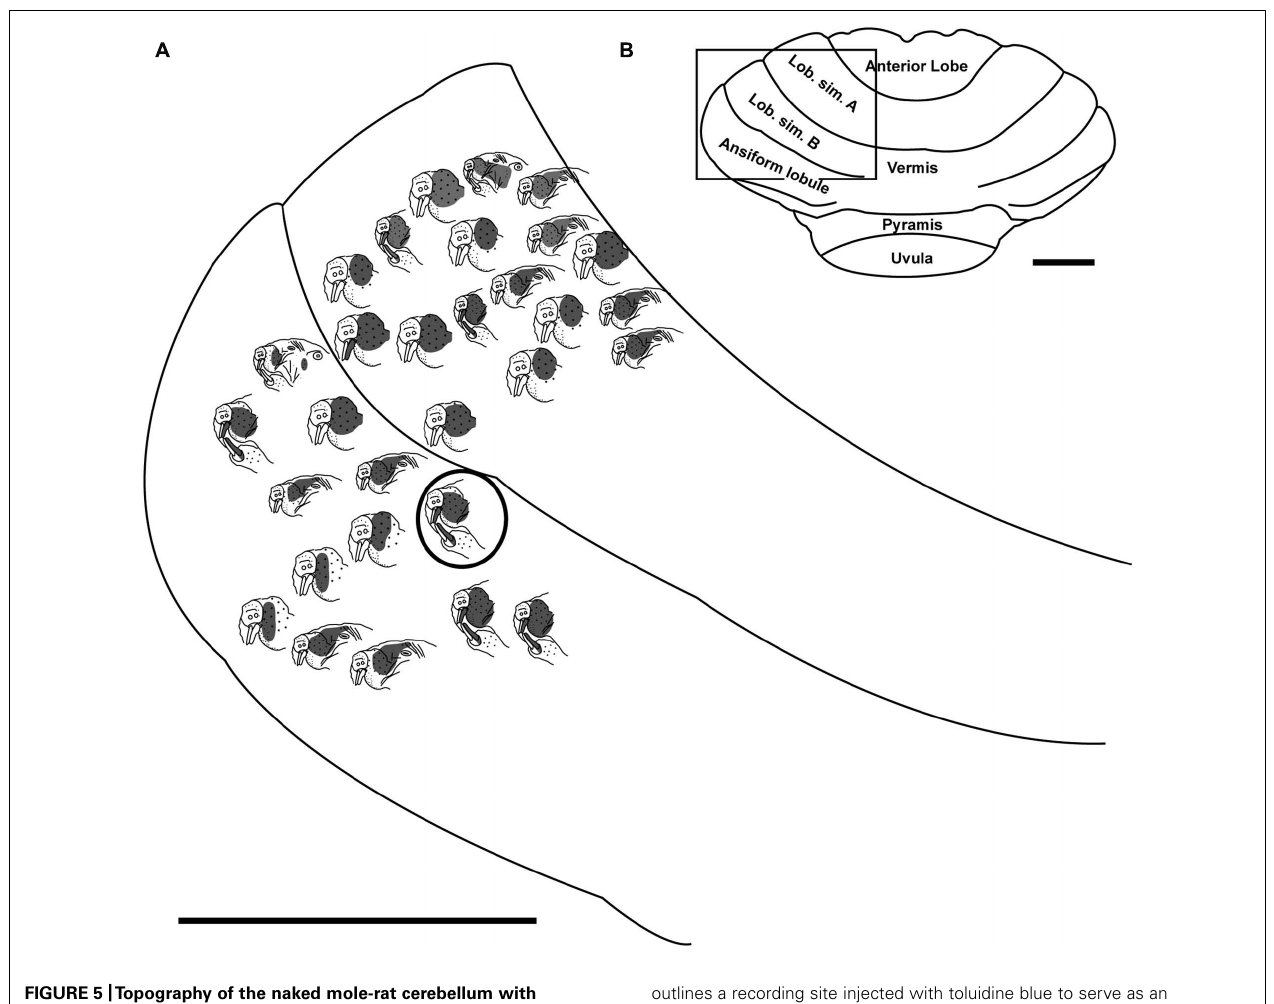
outlines a recording site injected with toluidine blue to serve as an anatomical landmark following termination of the experiment. (B) Illustration of the naked mole-rat cerebellum with a box delineating the area exposed by craniotomy. Dorsal view, rostral is up. Animal #030409. Scale bars: 1 mm for both (A,B)